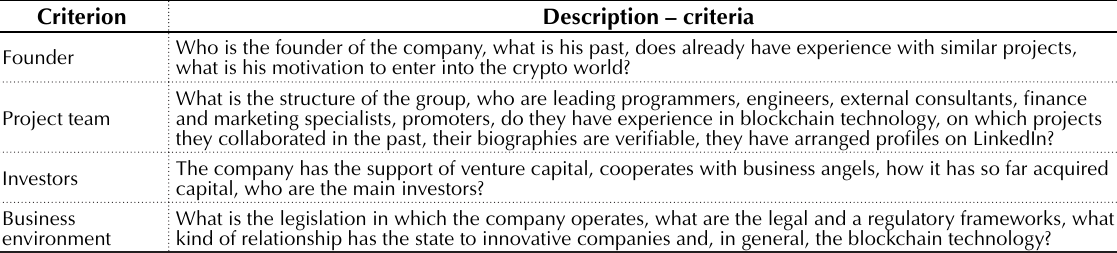
Figure 1. Model for evaluation of ICO projects Table 1. Dimension “The